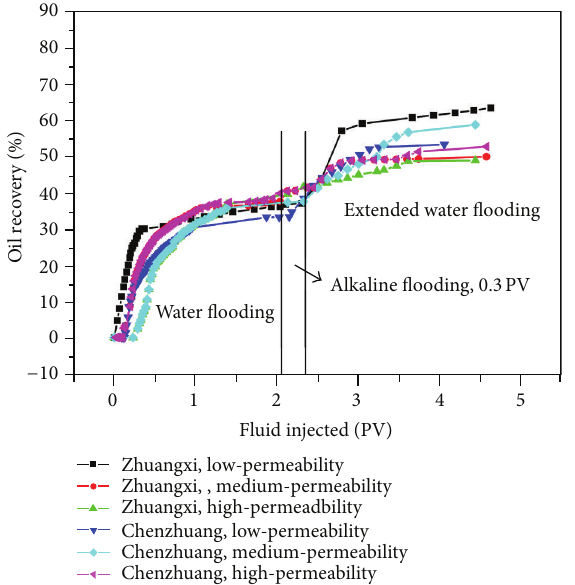
Figure 5: Oil recovery curves for different permeability sandpacks (alkaline concentration = 0.5wt%).